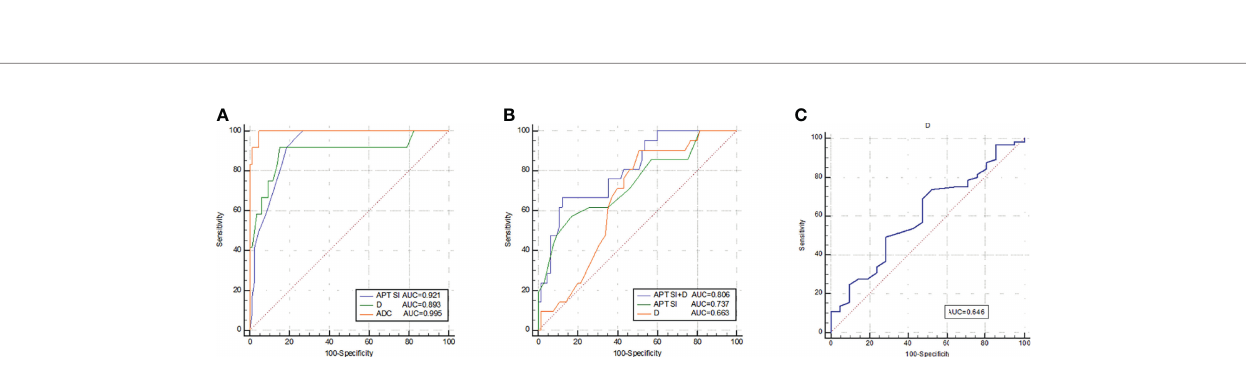
FIGURE 6 | ROC curves of APT SI, D, and ADC for discrimination between MC and AC (A) ; ROC curves of APT SI, D, and APT SI combined with D for discrimination between low- and high-grade AC (B) ; and the ROC curve of D for discrimination between positive EMVI and negative EMVI (C) . All parameters were with signi fi cant differences between the groups.